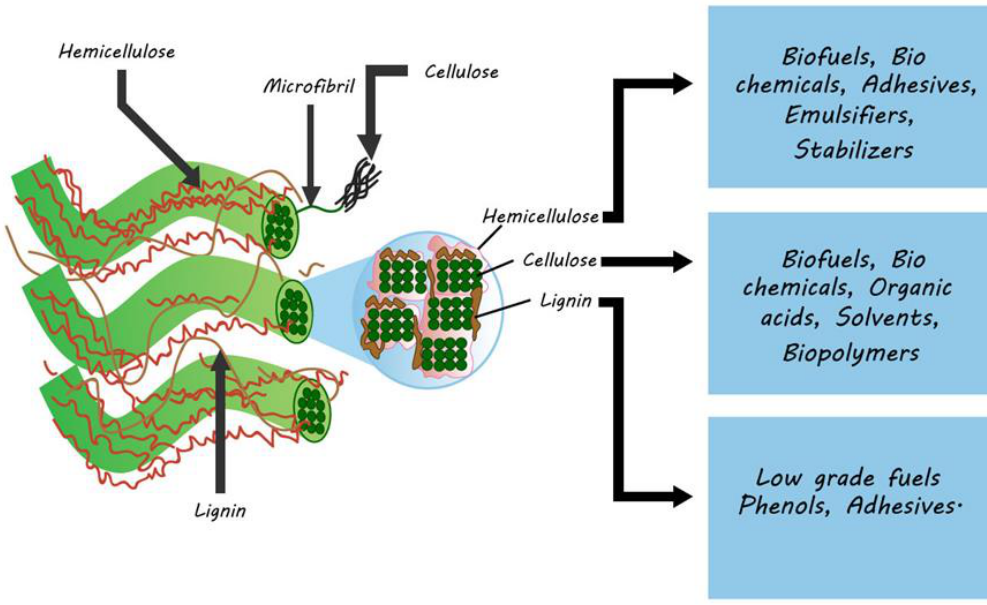
Figure 1. Structure of lignocellulosic biomass and the products of its components [23].